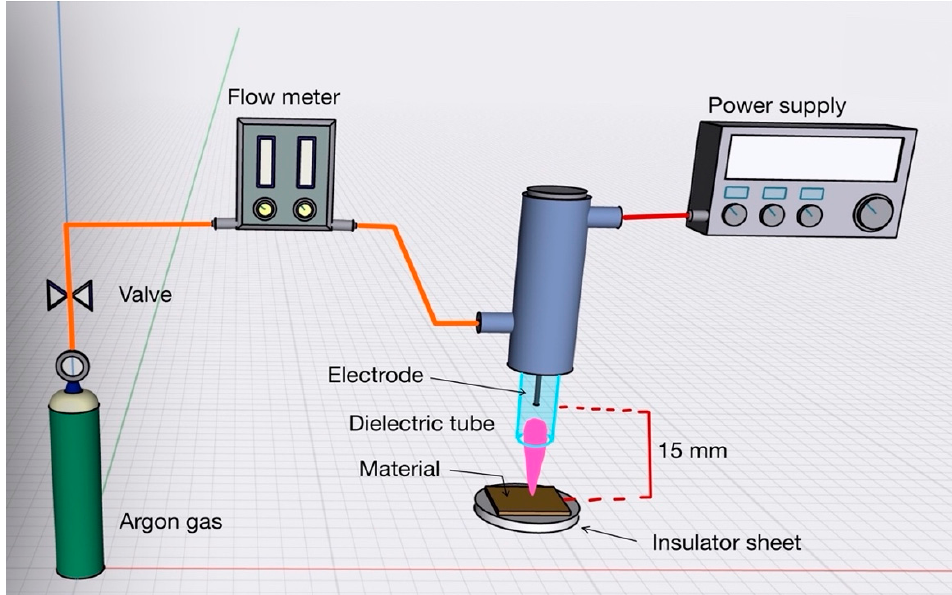
Figure 1. Schematic diagram of the atmospheric-pressure plasma jet system for the surface modifi- cation of materials.